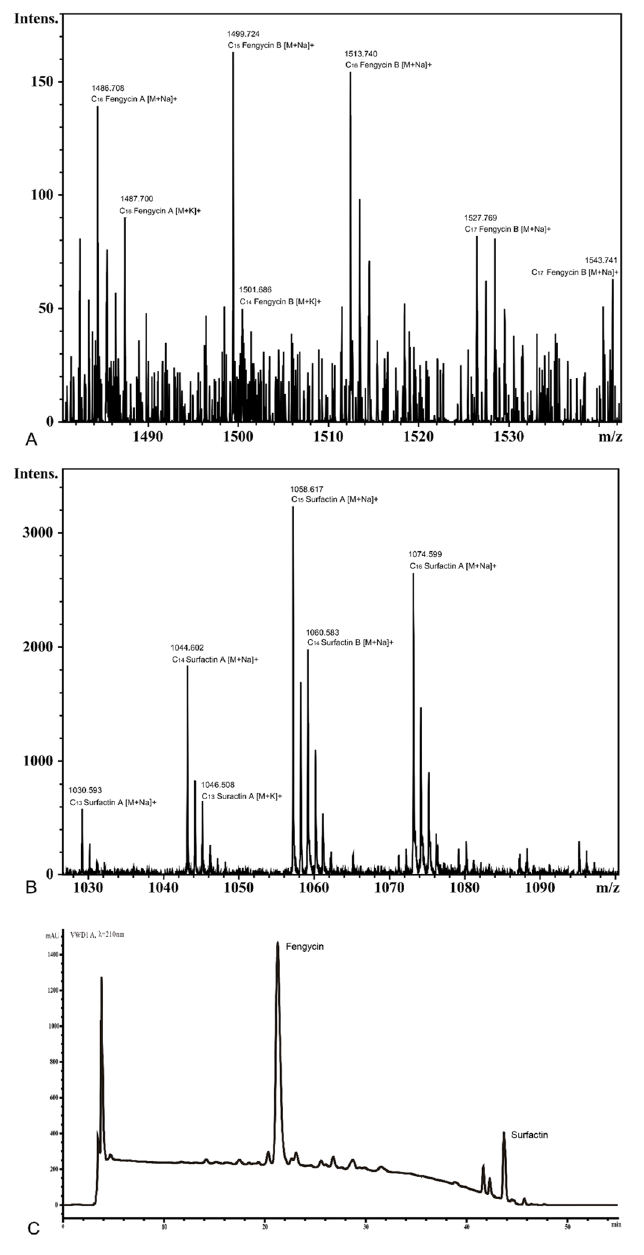
Figure 10. MALDI-TOF-MS and HPLC analysis of lipopeptide in B. halotolerans KKD1. ( A ) MALDI- TOF-MS analysis of surfactin in B. halotolerans KKD1. ( B ) MALDI-TOF-MS analysis of fengycin in B. halotolerans KKD1. ( C ) HPLC analysis of lipopeptide in B. halotolerans